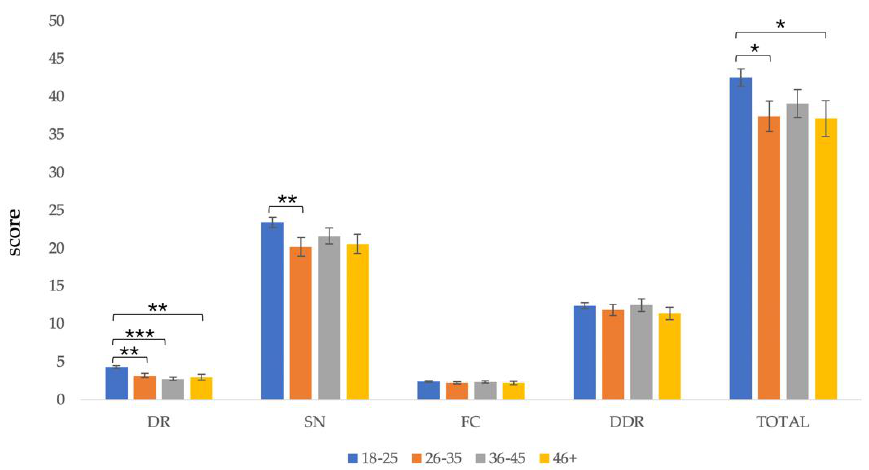
Figure 2. Comparison of C-GNKQ scores between different age groups. Error bars represent standard errors. * indicates p < 0.05, ** indicates p < 0.01, and *** indicates p < 0.001. DR: dietary recommendations, SN: sources of nutrients, FC: daily food choice, and DDR: diet–diseases relationship.